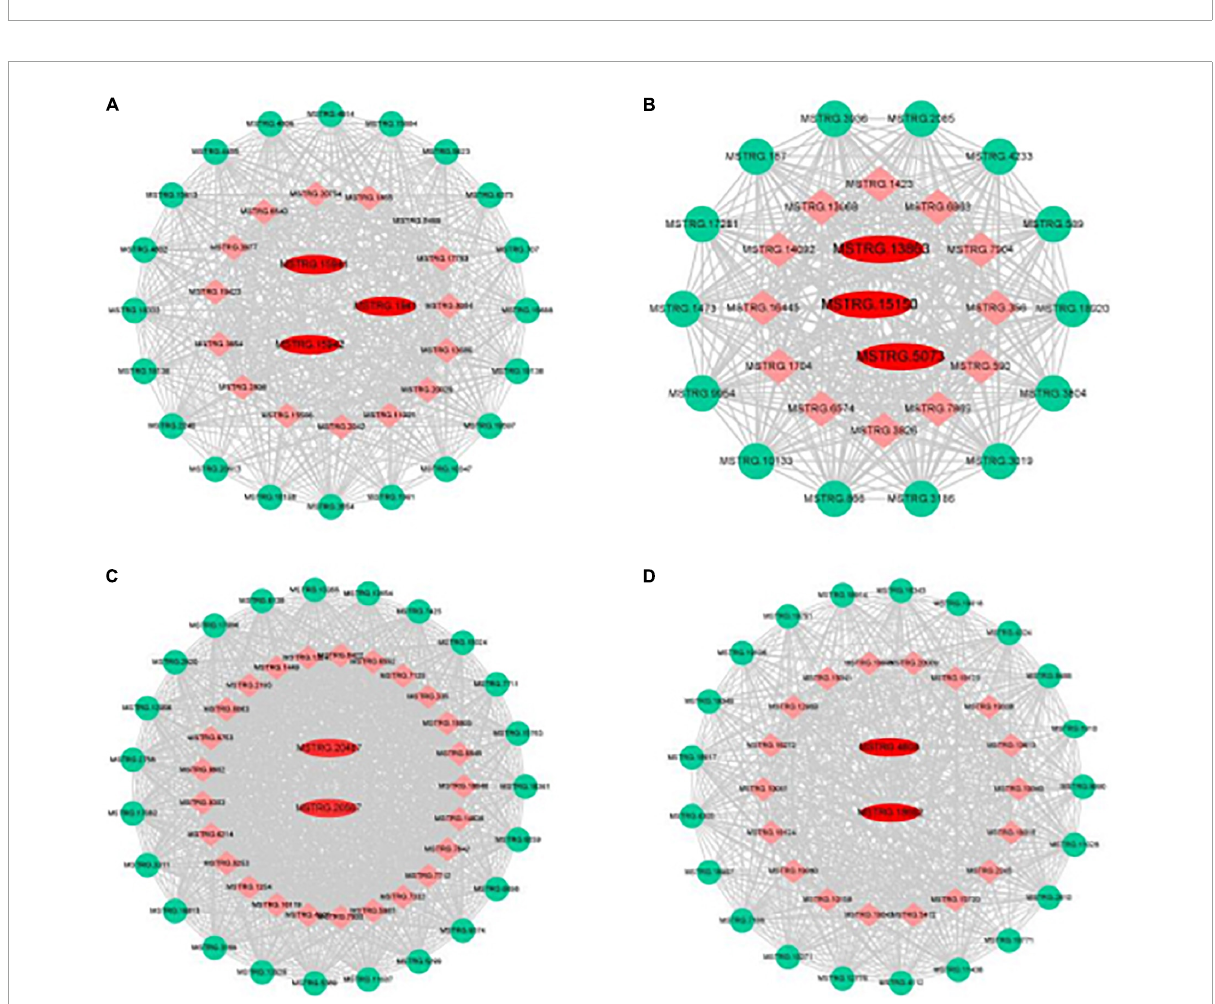
FIGURE7 Gene co-expression networks and hub genes of (A) green, (B) purple, (C) turquoise, and (D) salmon modules. Red, hub gene; Green, transcription factor; Orange, Other genes.